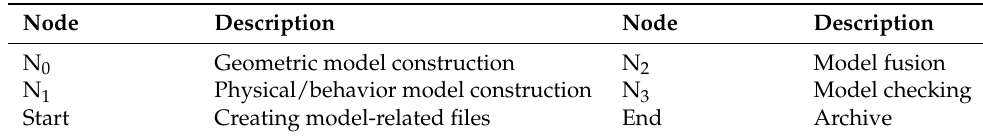
Table 1. Description of some activities in the workflow.